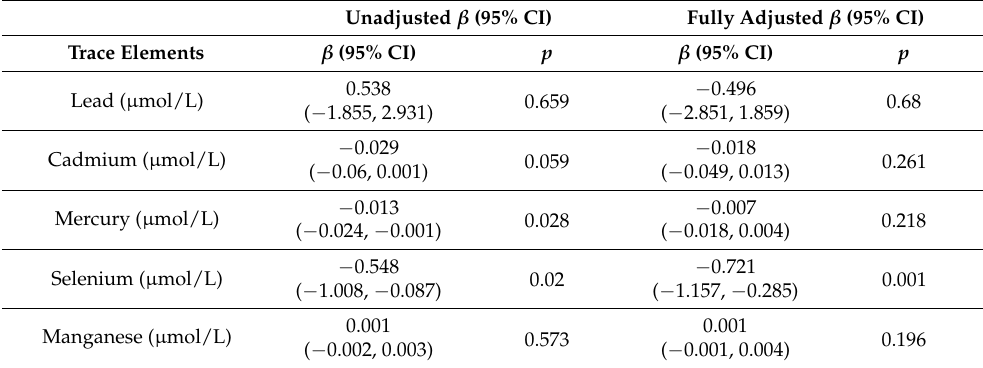
Table 2. Associations between circulating concentrations of trace elements and liver